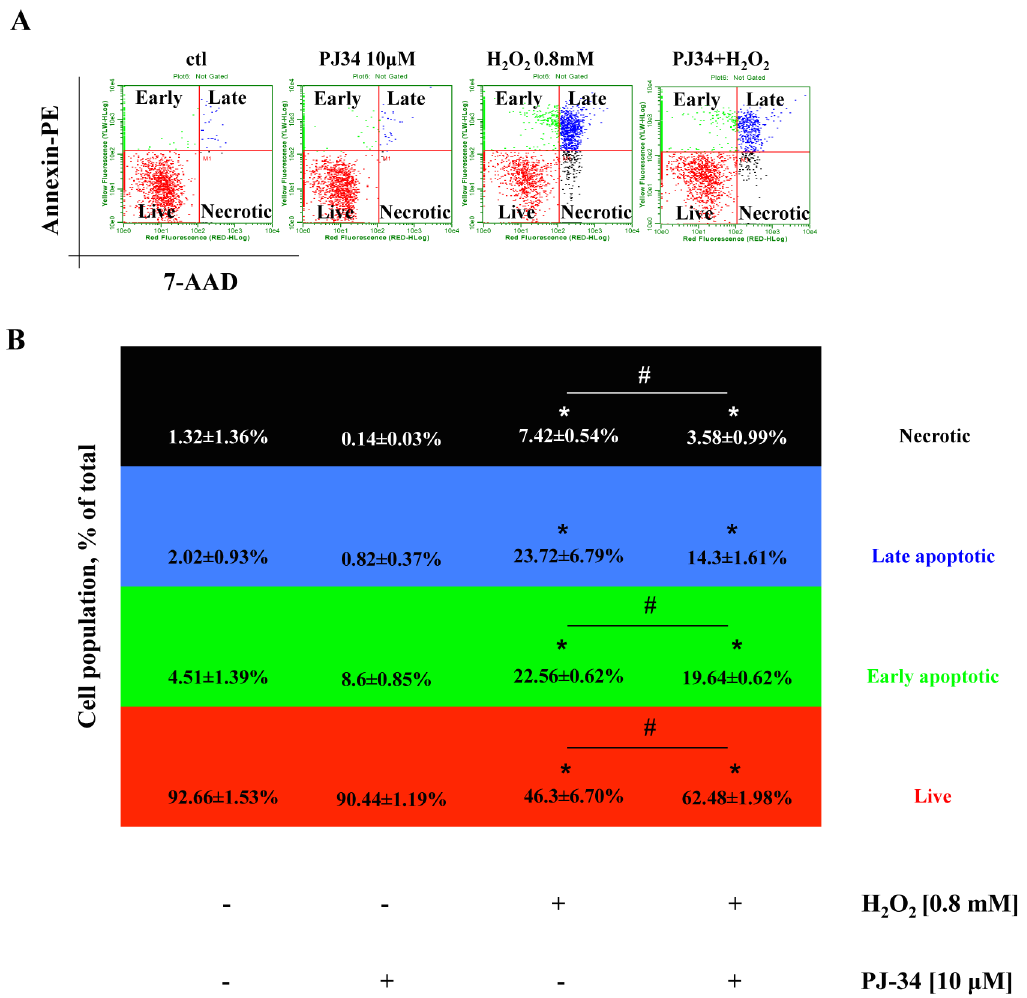
Fig 7. Inhibition of PARP-1 reduces subpopulations of apoptotic and necrotic cells induced by H 2 O 2 . C2C12 myoblasts were exposed to 0.8 mM H 2 O 2 for 24h in the presence or absence of the PARP inhibitor PJ34 (10 μ M). PJ34 reduced the oxidant-induced death of the myoblasts by decreasing the proportion of the necrotic, early and late apoptotic cell populations. Representative dot plots (A) and analysis (B) are shown. One-way ANOVA was used for determining significance between groups. * shows significant differences, p (cid:1) 0.05, in the cell response to H 2 O 2 relative to controls, while # shows significant protective effect of PJ34, p (cid:1) 0.05. Data representative of 3 different determinations conducted on different experimental days are shown. (Total cell number in each group was set to